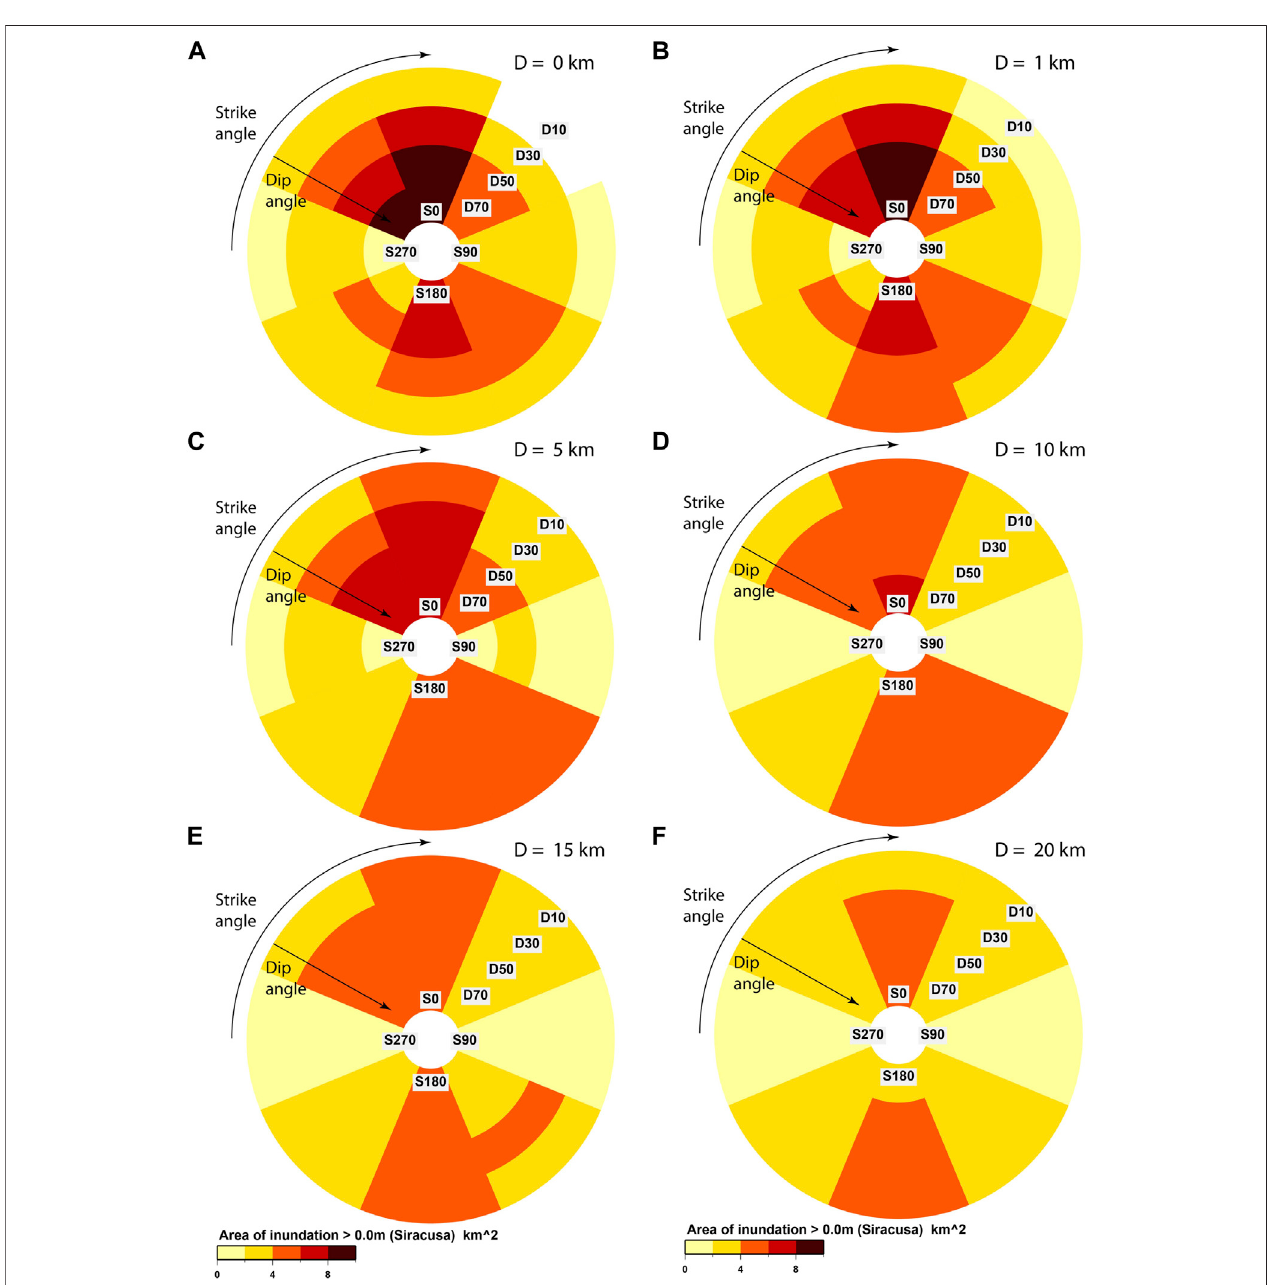
FIGURE13| AreaofinundationinthebayofSiracusaasafunctionofstrike,dip,anddepthfortsunamiswiththeearthquakesourceswithrake (cid:1) 90 o .Notethatthe colour scales in Figures 12 , 13 are different with lower areas of inundation for the smaller bay at Siracusa. Panels (A – F) indicate respectively inundation resulting from earthquakes with depths 0, 1, 5, 10, 15, and 20 km.